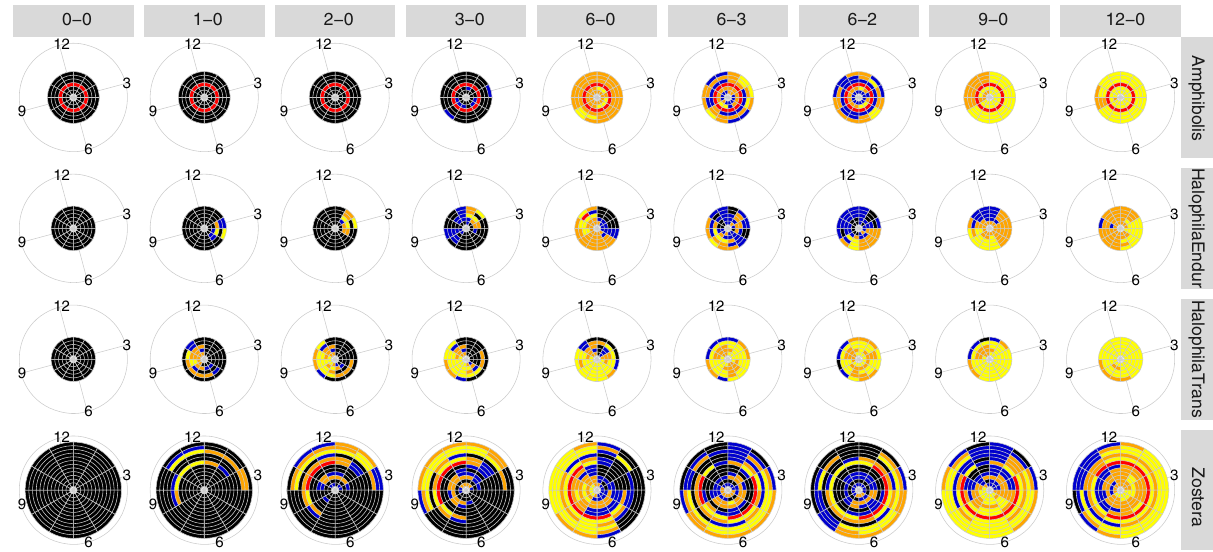
Fig. 5 Maximum allowable light reduction or, equivalently, minimum light during dredging. Data are grouped by seagrass genus, life history and dredging design. Each ring on a pie corresponds to a site, ordered from southernmost to northernmost from innermost ring to outermost ring. Satisfaction of, at minimum, the recovery criterion and additionally resistance and persistence were considered in determining light reduction thresholds. Minimum light levels are colour coded: black for 0% light during dredging, blue for 25%, orange for 50%, yellow for 75% and red for no light reduction allowed. A score that is not red corresponds to an ecological window. For resilience criteria scores of ecological windows corresponding to 25, 50 and 75% minimum light during dredging, refer to Supplementary Figs. 12 – 14,